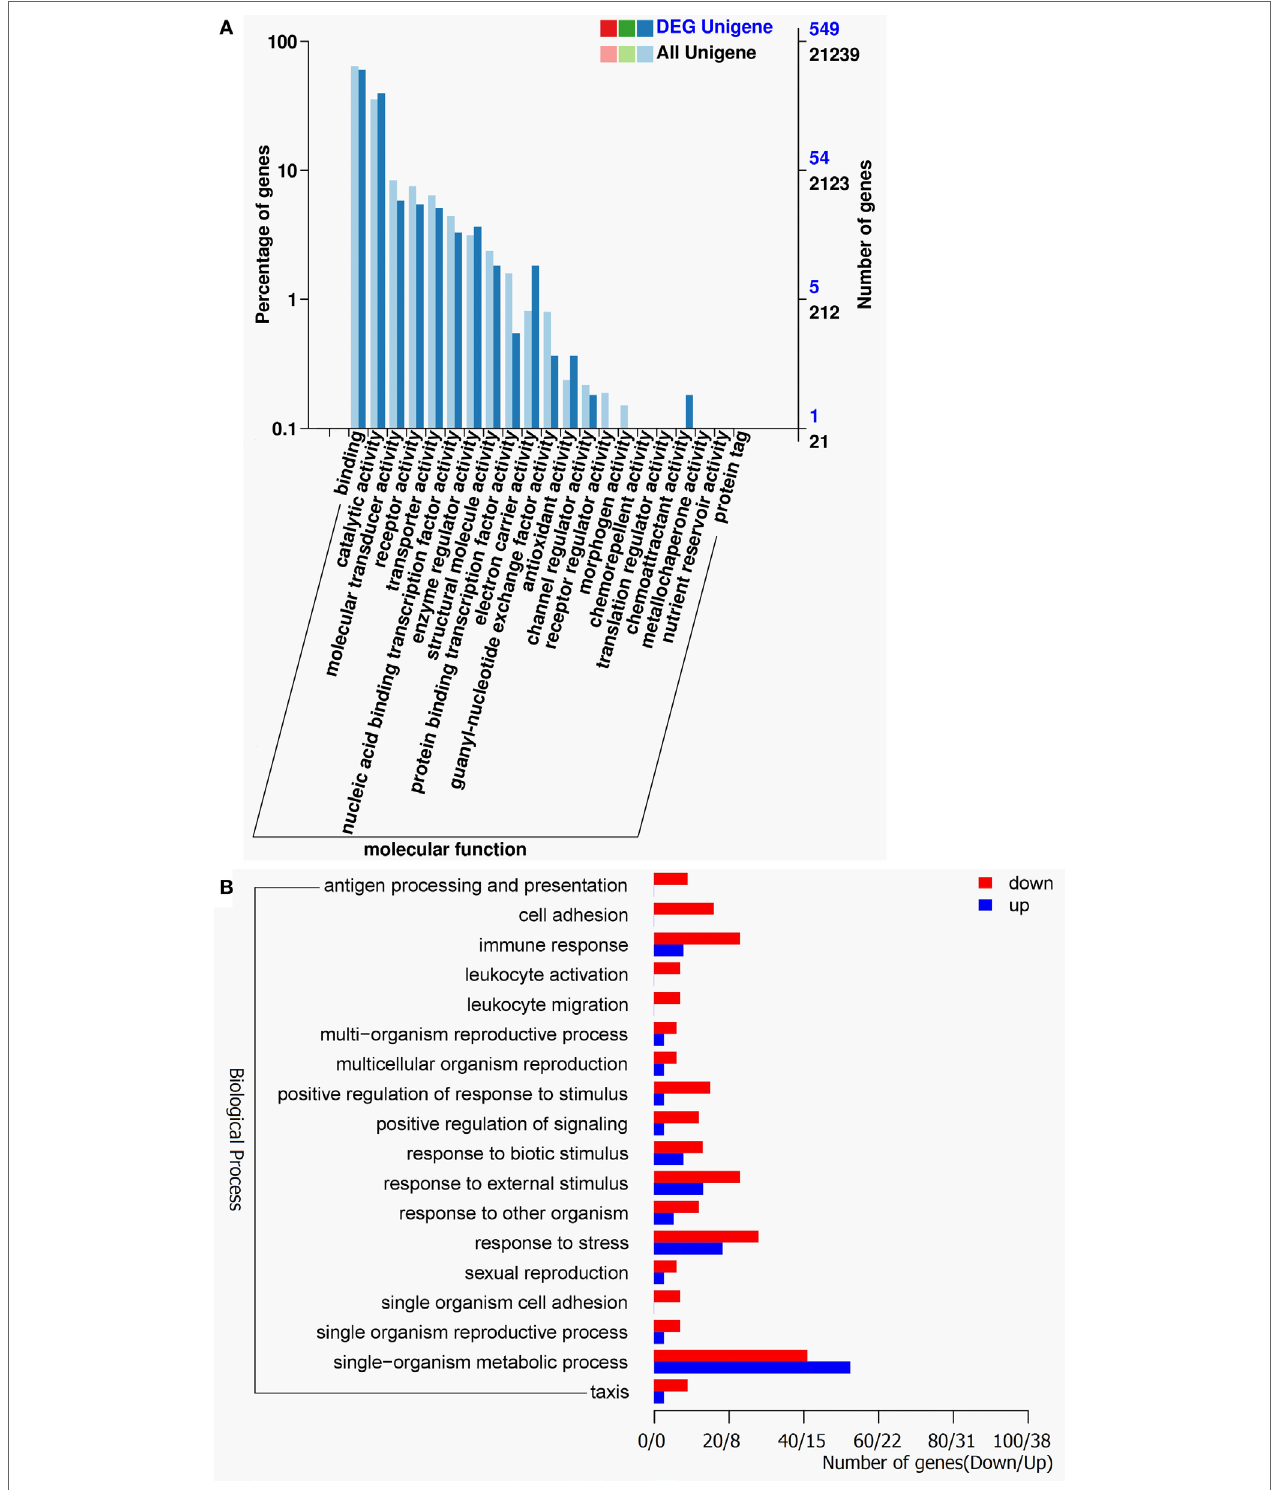
FigUre 3 | Gene ontology (GO) functional annotation. (a) GO functional annotation according to molecular function. In all 21,239 Unigenes and 549 DEG Unigenes were assigned to at least one GO term and were grouped into molecular function. Right y -axis represents number of unigenes in a category. Left y -axis indicates percentage of a specific category of unigenes in each main category. (B) GO functional annotation according to biological process. Red columns represent differentially expressed genes for downregulation and blue columns for